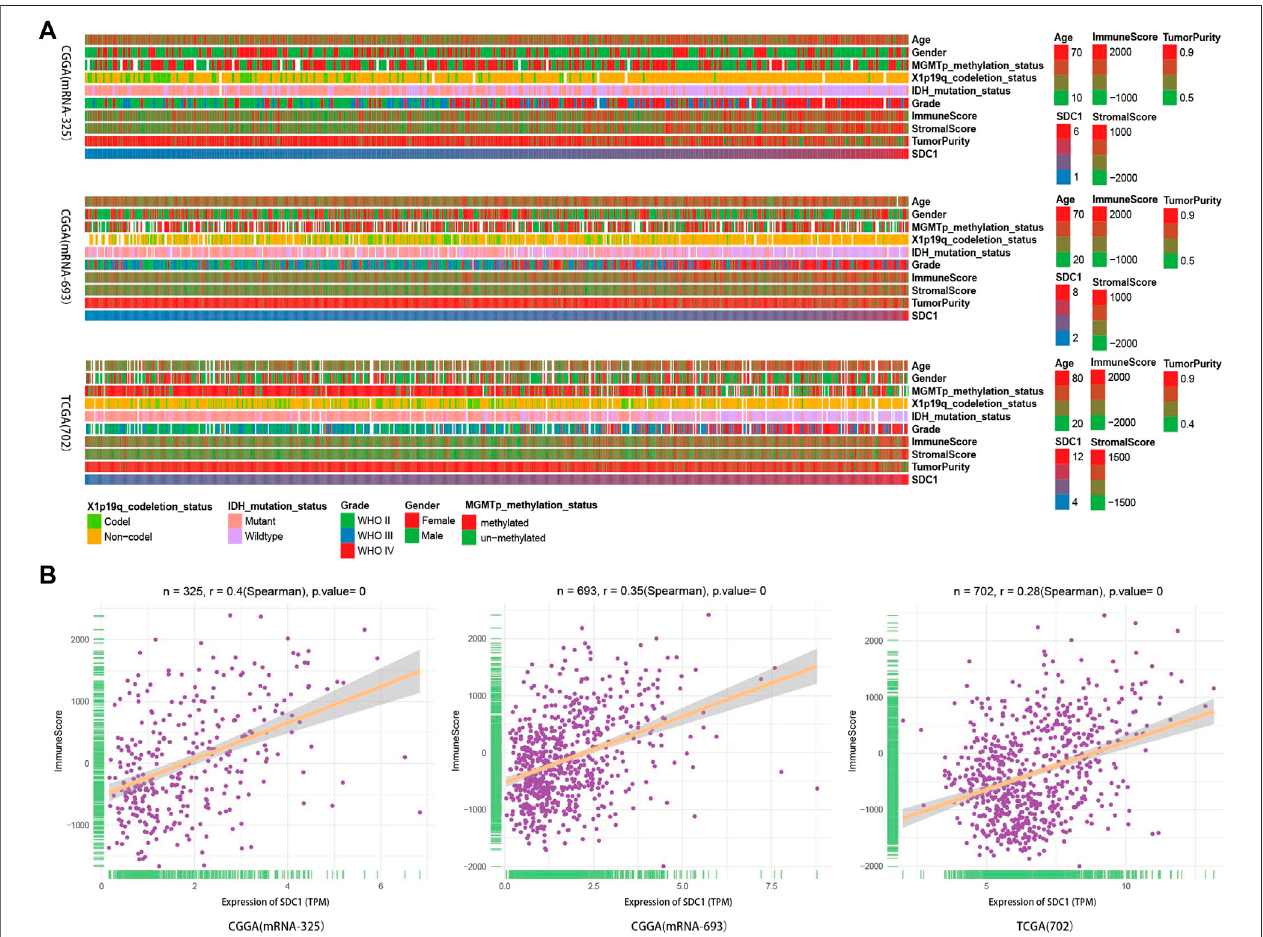
FIGURE2| Thelandscapeofgliomaimmunescore,clinicalandmolecularcharacteristicsinassociationwiththeexpressionofSDC1. (A) Transcriptomedatasetof glioma specimens in CGGA (mRNAseq_325 dataset and mRNAseq_693) and TCGA RNAseq were used to assess the immune score of glioma. (B) The relationship between the expression of SDC1 and glioma immune score was estimated. The patients ’ characteristics of glioma further ensure the reliability of landscape of the expression of SDC1 and immune score. The association between the immune score in glioma samples and continuous variables was assessed using Spearman correlation